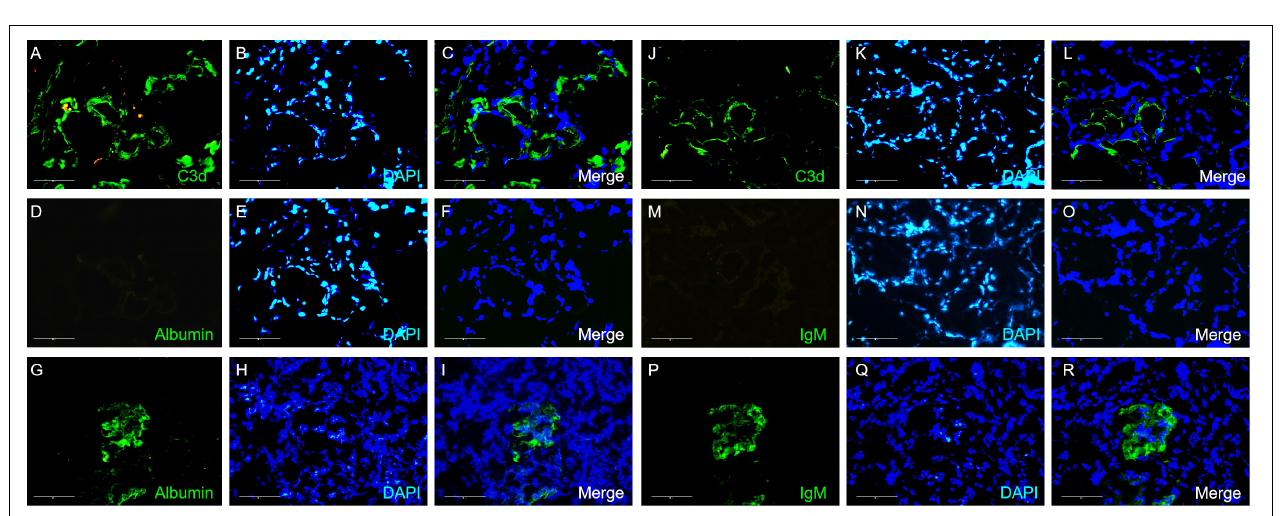
FIGURE 4 | Images of C3d (A–C,J–L) , albumin (D–F) and IgM (M–O) immunofluorescence staining in arterionephrosclerosis. (A,J) Showed C3d staining (green) on arterioles. (D,M) Showed no staining for albumin and IgM of the same arteriole in (A,J) , respectively. (G–I,P–R) Showed albumin and IgM staining (green) in positive controls, respectively (Magnification, 400 ×